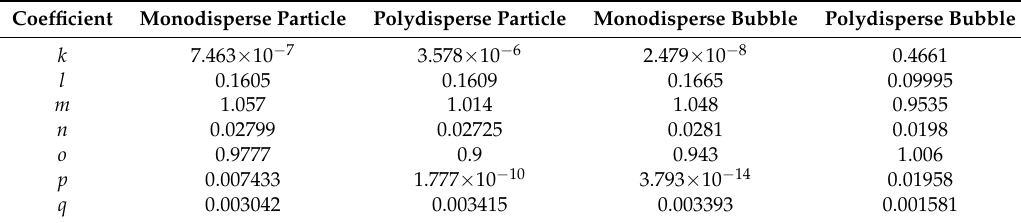
Table 1. Coefficients for fits of Equations (14)–(17) for the simulated results with a 95% confidence interval in the fit. The equation fit was determined with